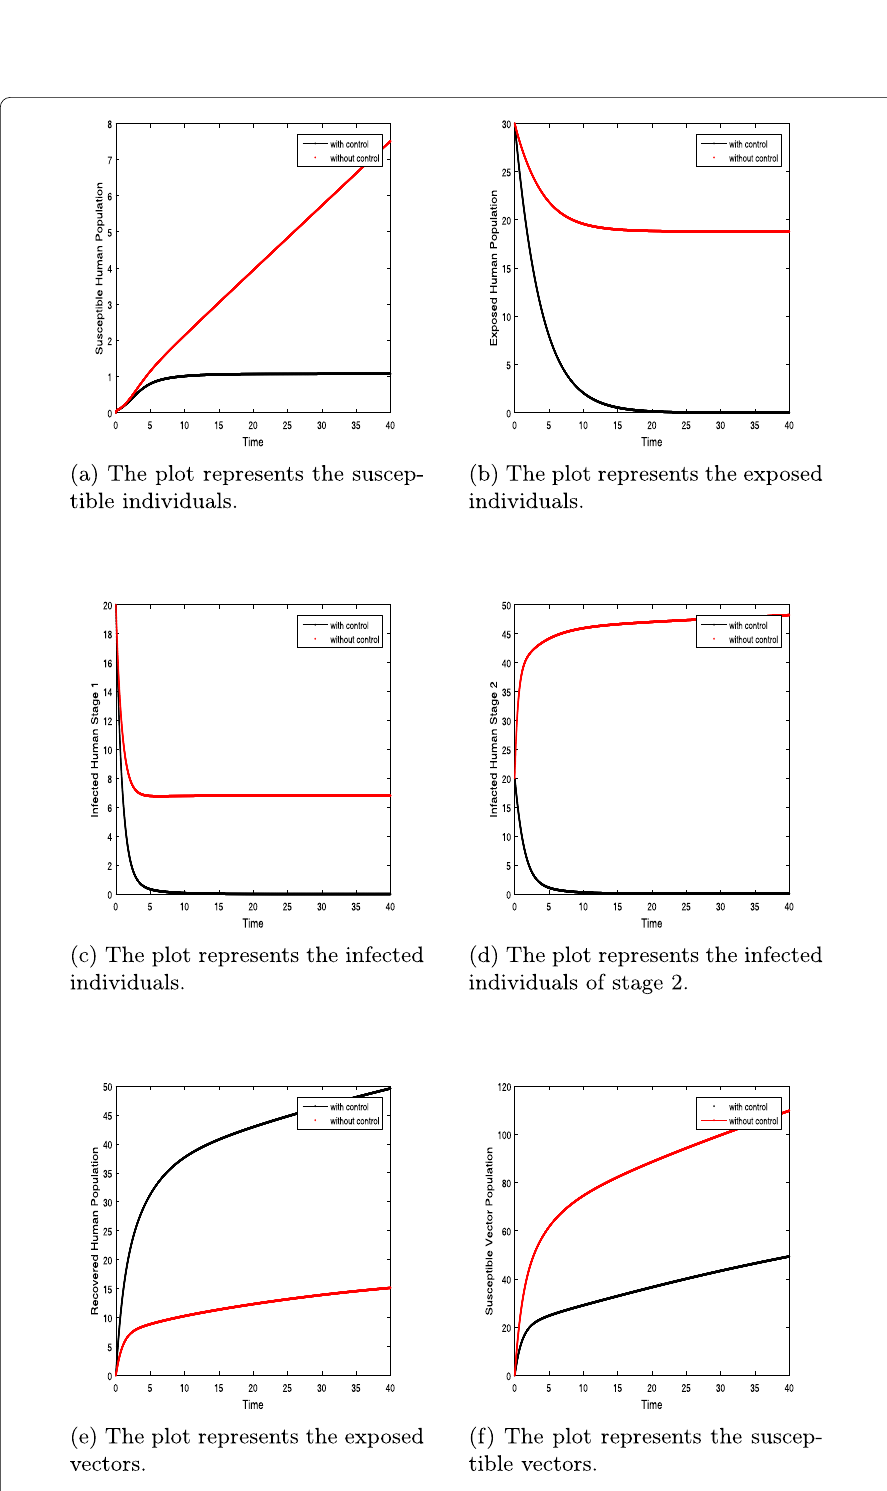
Figure 2 Plots of different classes showing the difference between “with control” and “without